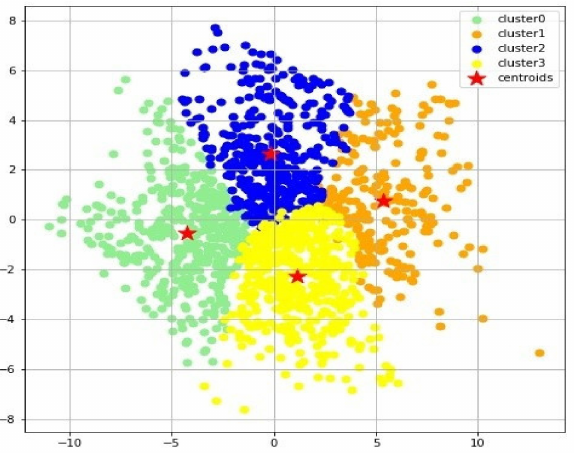
Figure 2. Distribution of ADNI Alzheimer’s patients after being partitioned into four clusters or separable sub-populations (cluster 0, cluster 1, cluster 2, cluster 3) using t-SNE dimensional reduction followed by k-means clustering with k = 4. Red star(s) represents the centroid of each